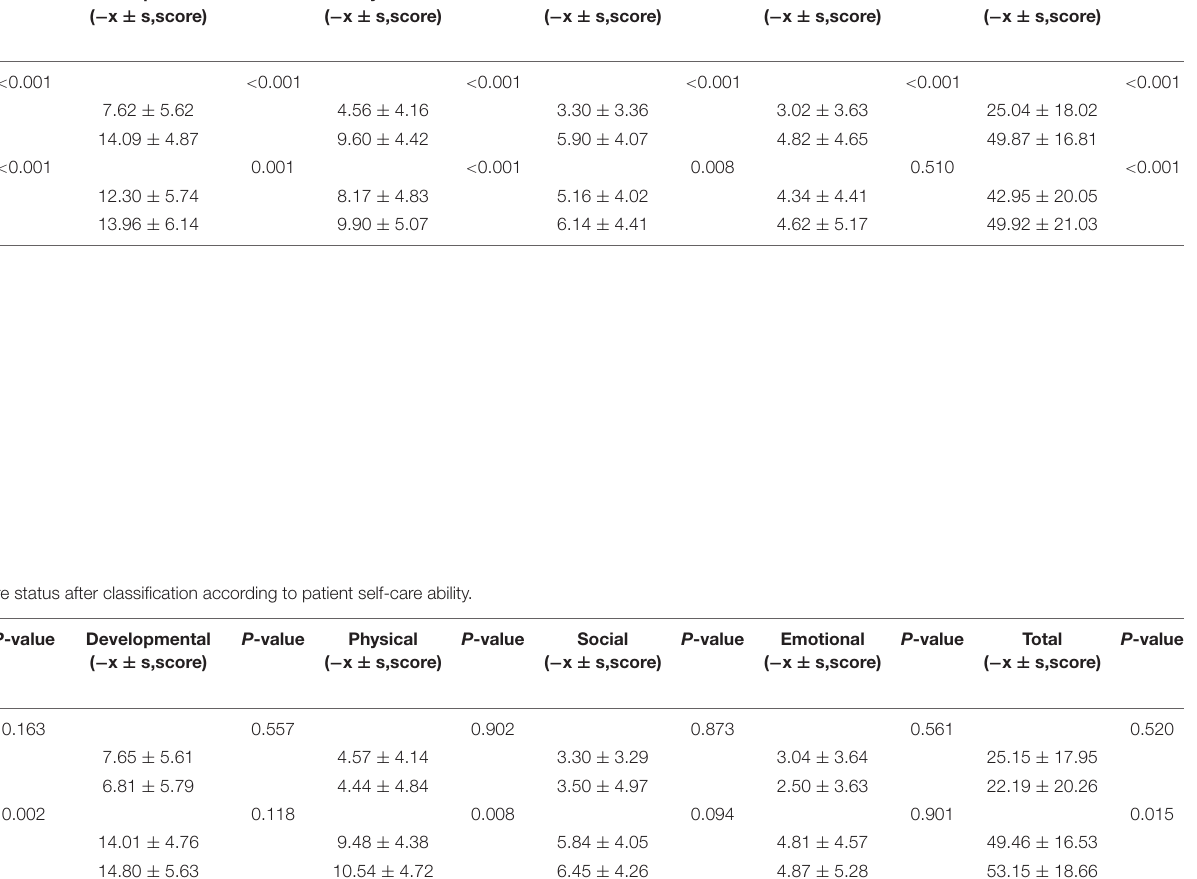
TABLE 4 | CBI scores of the family of patients with AD based on the caregiving status. Burden classification n Time- dependence